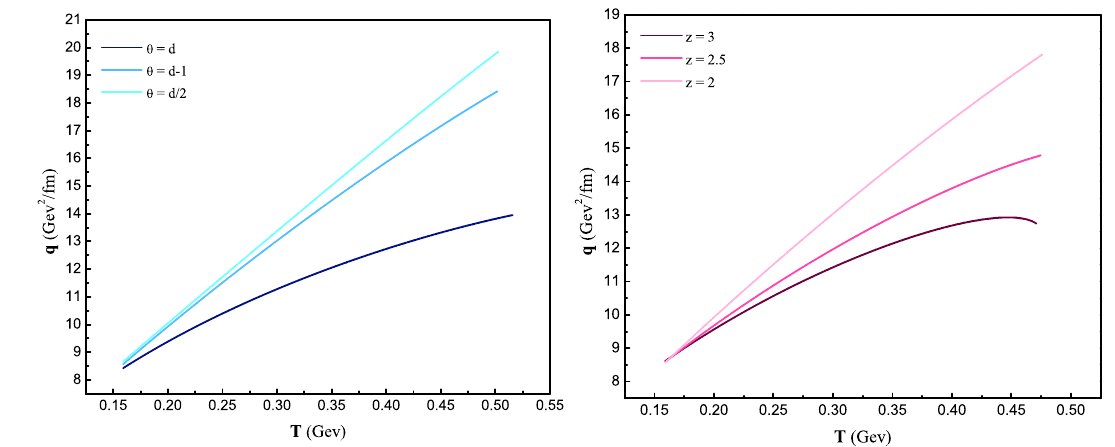
Fig. 3 Left: jet-quenching versus temperature in different θ at z = 2 and Q = 1. Right: jet-quenching versus temperature in different z at θ = d − 1 and Q =